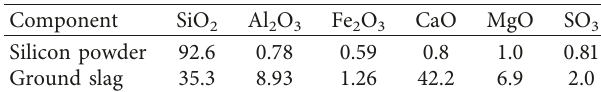
Table 1: Chemical composition of silicon powder and ground slag